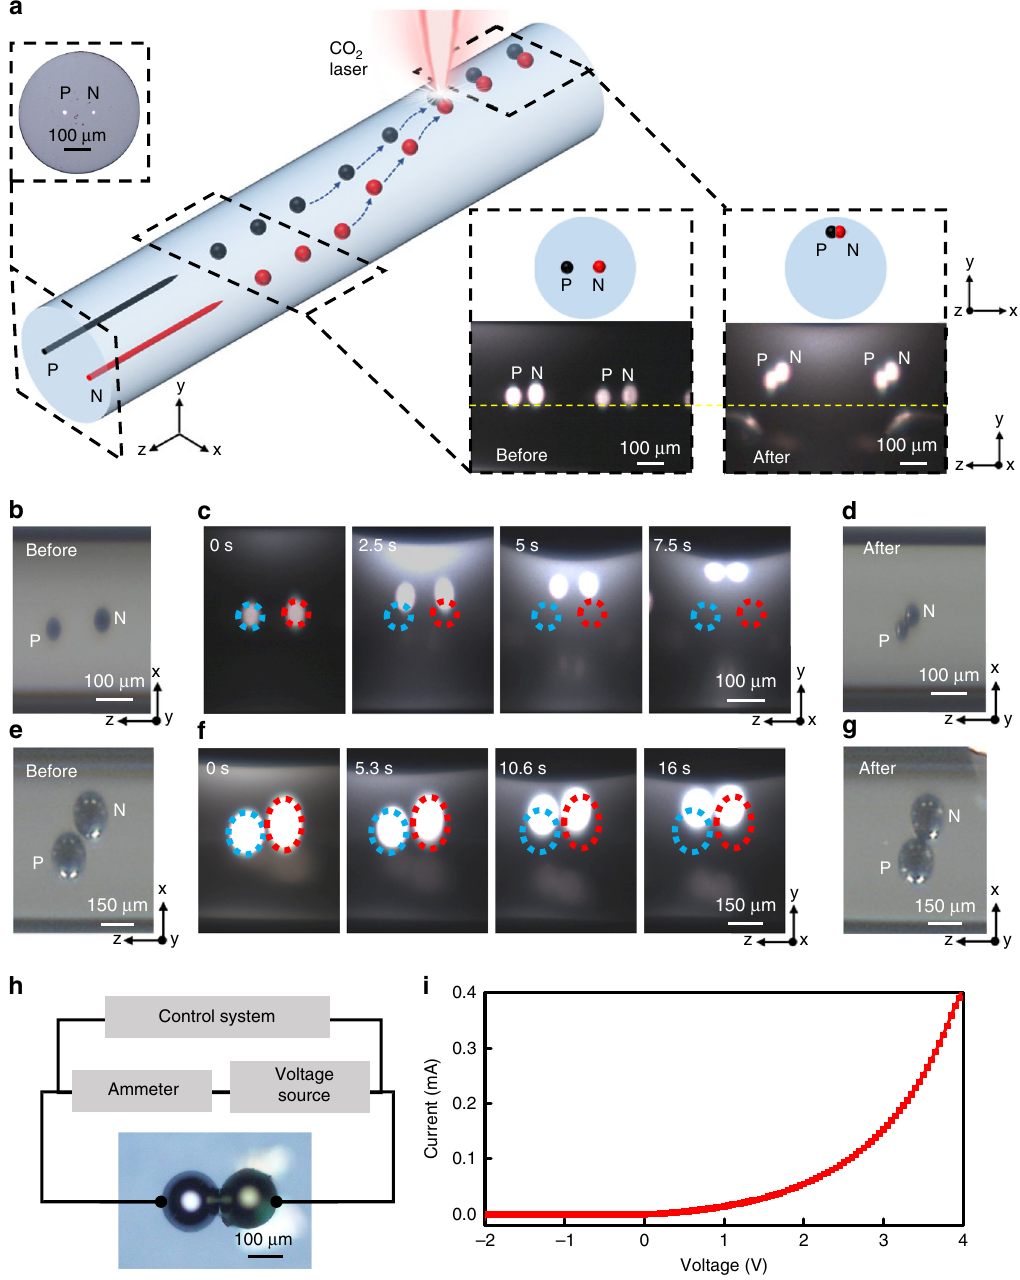
Fig. 4 CO 2 laser induced thermocapillary convection for structures reconstruction and p-n homojunction molecule fabrication. a Schematic of the asynchronous break-up of a dual-core germanium fi bre and in- fi bre structure reconstruction based on the CO 2 laser induced thermocapillary convection for p-n molecules fabrication. The thermocapillary convection collects the p- and n-type spheres, moves the dislocation particles and assembly them into one p-n molecule. The insert on the top left corner shows the cross-section of the dual-core (p- and n-type) germanium fi bre. The insets on the bottom show the separated p- and n-type spheres before processing and the contacted p-n junction molecule after processing. b Dislocated p- and n-type germanium particles with the same diameter of 40 μ m. The spatial distance between two particles is around 180 μ m. c Snapshots of in- fi bre particles with a diameter of 40 μ m manipulated by the CO 2 laser power at different time-points. At the beginning ( t = 0 s), the p- and n-type particles are located at the right and left of the laser beam. Starting from the laser switched on, the particles are dragged, migrated towards the laser beam and eventually contact with each other to form a p-n molecule ( t = 7.5 s). d The p-n molecule with smaller in- fi bre germanium particles is formed by the laser induced thermocapillary convection. e The dislocated p- and n-type germanium particles with diameters of 160 μ m. The spatial distance between the particles is around 40 μ m. f Snapshots of in- fi bre particles with a diameter of 160 μ m being manipulated by the CO 2 laser power at different time-points. The moving duration is 16 s. The particles show in elliptical shape due to the convex lens effect of the cylindrical silica cladding. The actual spheres are in spherical shape as shown in h . g The p-n molecule with larger in- fi bre germanium particles is formed by the laser induced thermocapillary convection. h Measurement diagram of the heavily doped dual-sphere germanium p-n molecule. i I – V characteristic of the dual-sphere germanium p-n